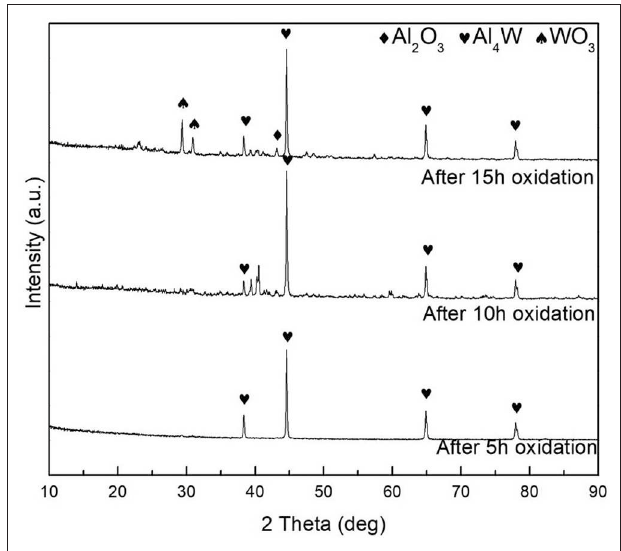
FIGURE 8 | X-ray diffractometer patterns of the samples S1 after cyclic oxidation test.